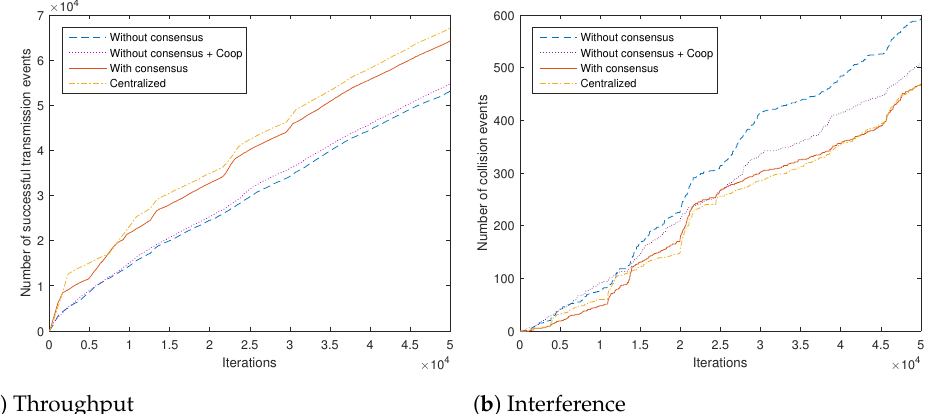
Figure 6. Total number of successful and failed transmission events in the network for different algorithms, versus number of iterations. Table 5. Different channels’ contribution to the total number of successful and failed transmissions in the